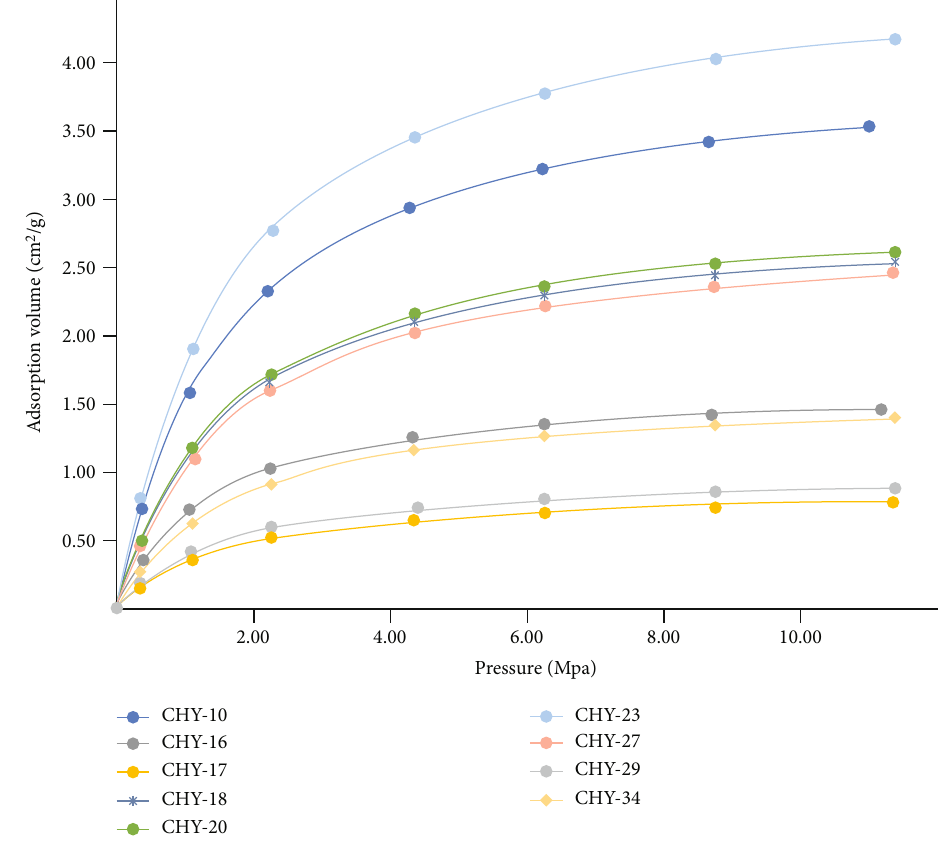
Figure 9: Methane isothermal adsorption curve of shale of Keluke Fm.